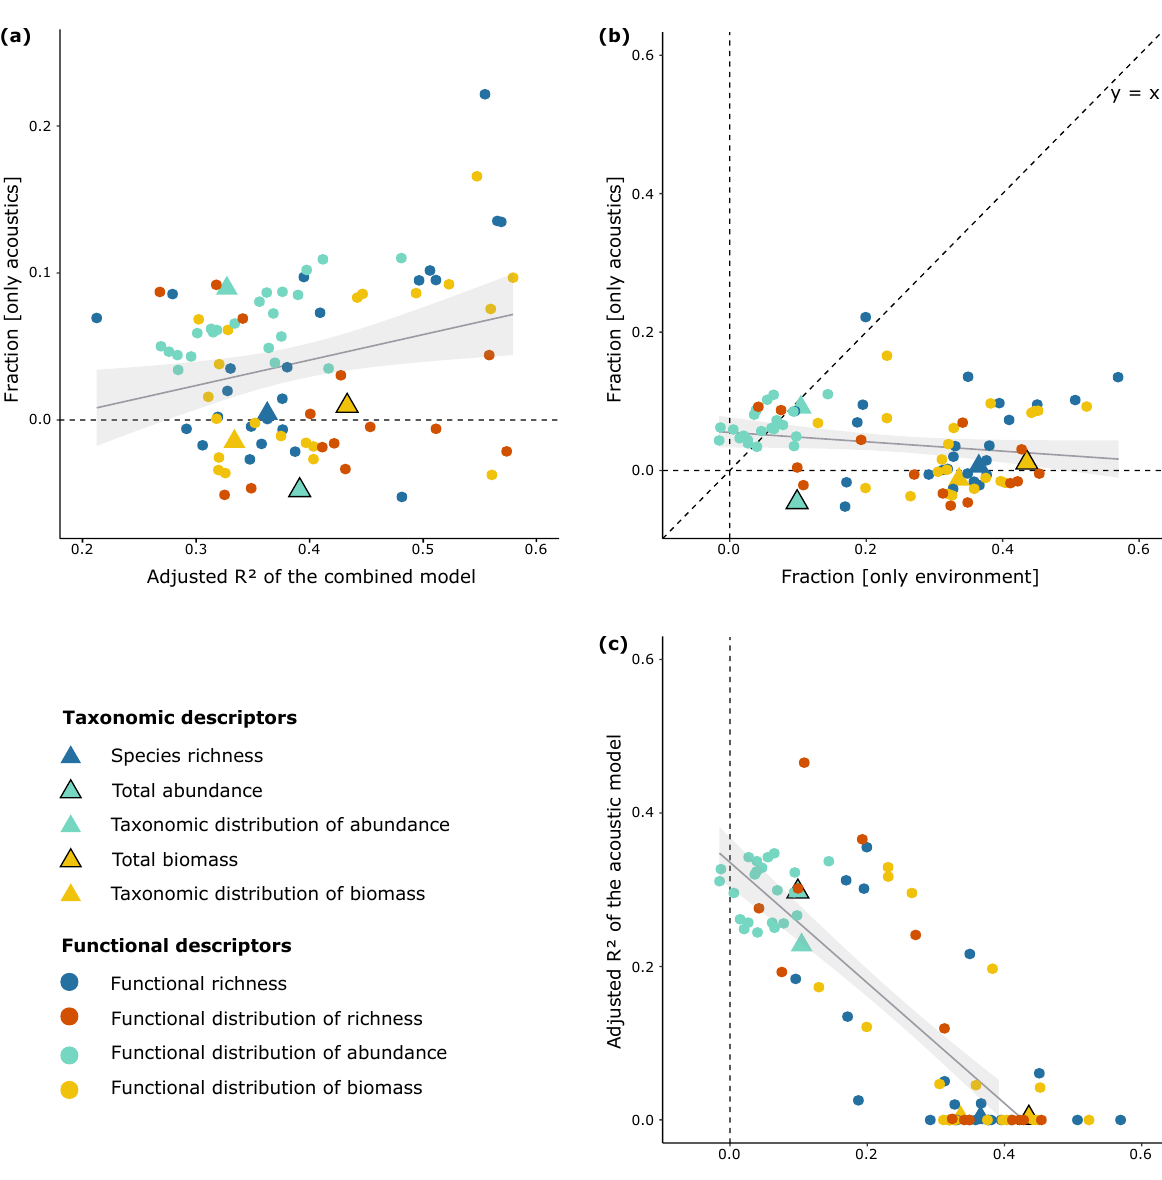
3.2. Test of the Added Value of Acoustic Data in Predicting Fish Assemblage Characteristics Of the 109 combined models, 86 were significant. Depending on the fish descrip- tor considered, the adjusted R 2 ranged from 0.14 to 0.60 for the environmental models [mean value ( ± sd) = 0.35 ± 0.09], from 0 to 0.47 for the acoustic models [mean value ( ± sd)